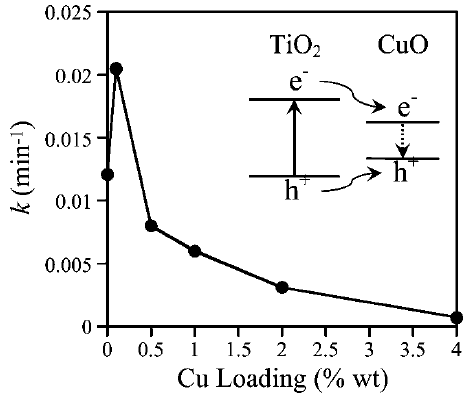
Figure 7. First-order rate constants ( k in min − 1 ) as measured by methylene blue degradation under UV irradiation. Synthesized CuO-TiO 2 nanocomposites with different copper loadings were used as the photocatalysts. Inset: a schematic diagram showing the photoinduced charge separation (e − in conduction band and h + in valence band) in TiO 2 , charge transfer from TiO 2 to CuO and subsequent charge recombination in CuO (dotted arrow). The difference between the conduction band edges of TiO 2 and CuO is estimated to be 0.75 eV. Reprinted with permission from [86]. Copyright American Chemical Society, 2008.